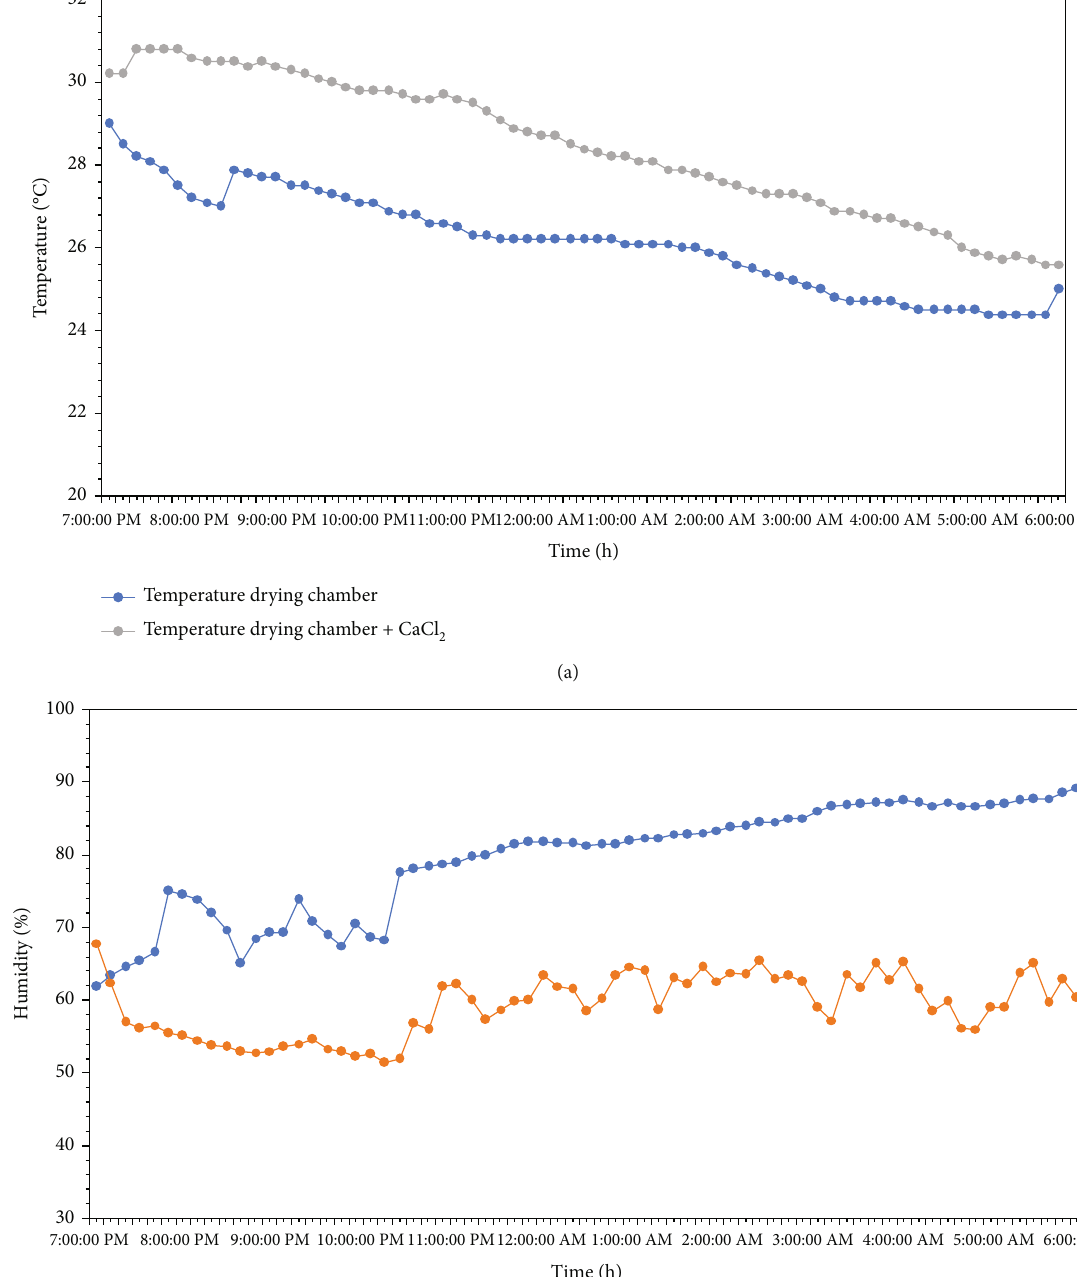
Figure 3: (a) Temperature inside the solar drying box at nighttime. (b) Relative humidity inside the solar drying box at